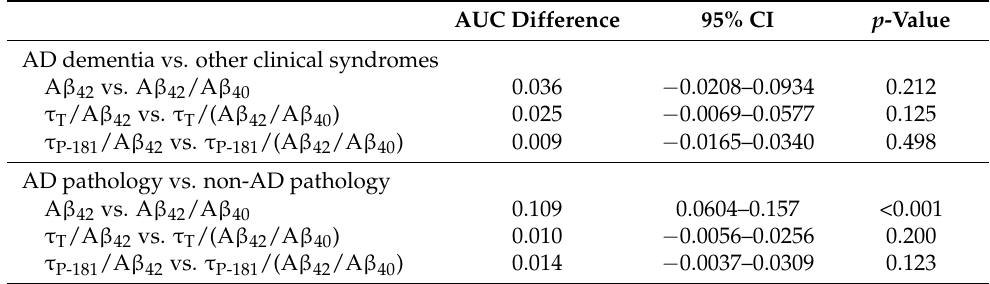
Table 3. Comparison of ROC curve AUCs by the De Long method. AUC: area under the curve; 95% CI: 95% confidence interval. AUC Difference 95%